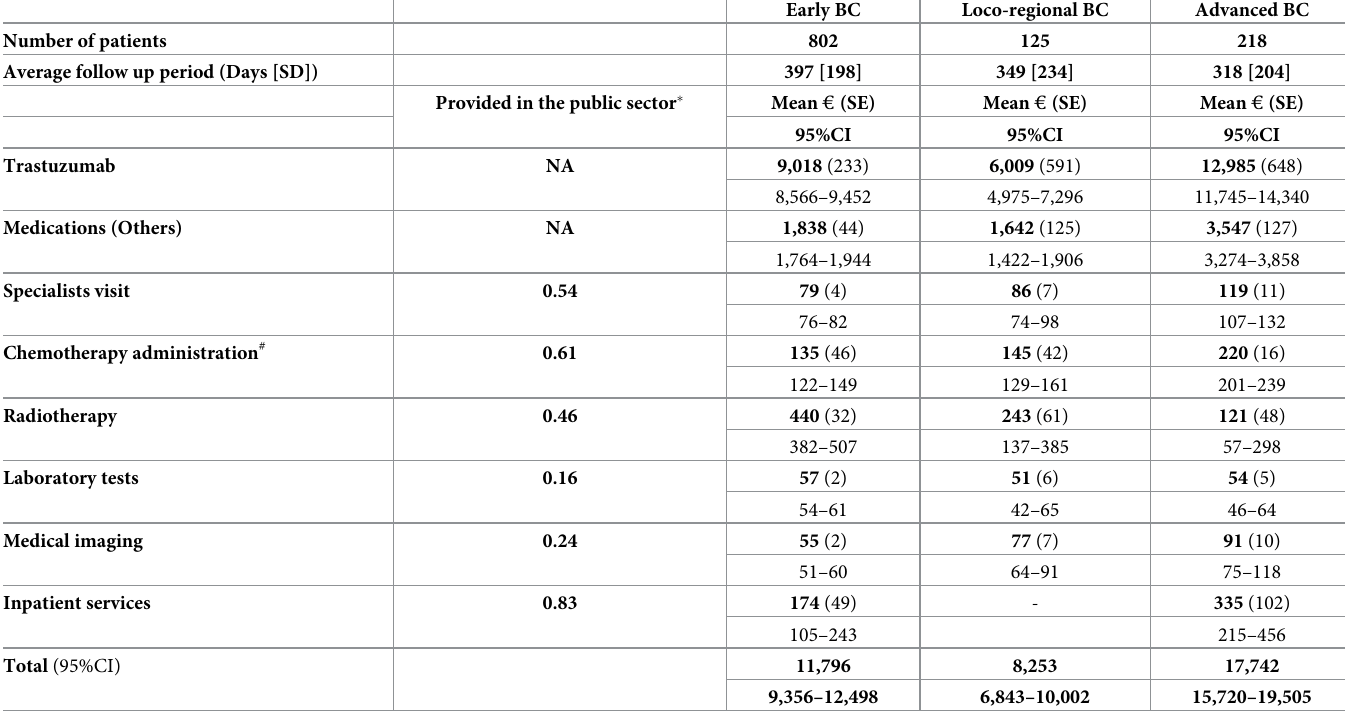
Table 4. The overall average costs (public and private sectors) in three stages of BC during the follow-up period. Results after applying nonparametric bootstrapping. Costs as of 20.03.2014 (1 € = 34,000